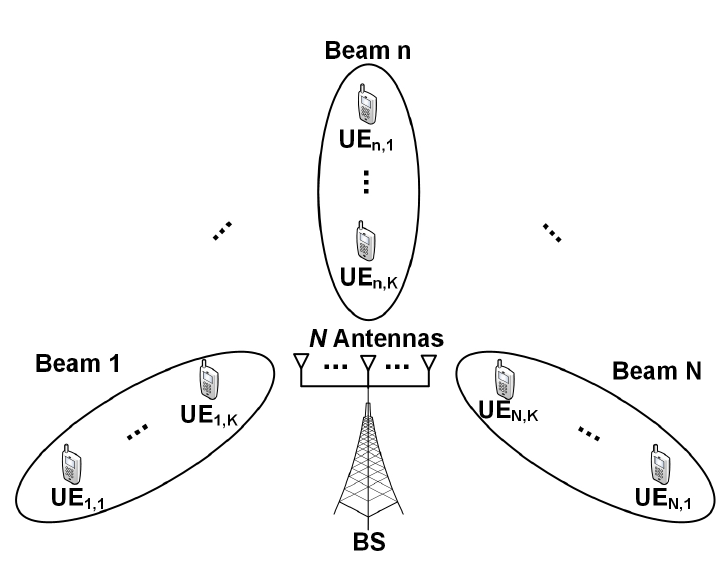
Figure 1. System